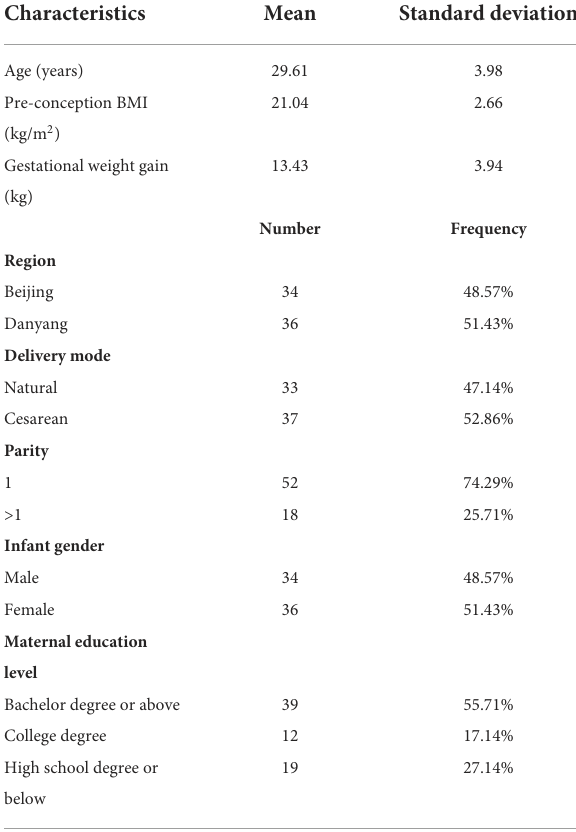
TABLE 1 Characteristics of mothers and infants